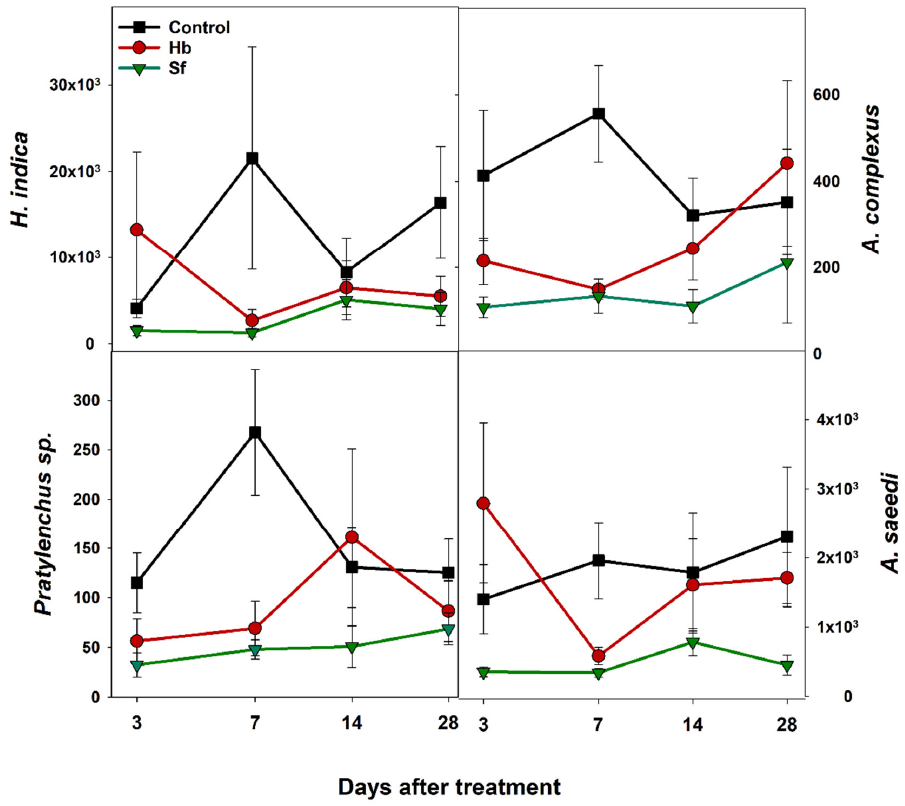
Figure 2. Read abundance of four indigenous nematode species in a citrus orchard for 28 days following augmentation of Steinernema feltiae (Sf), Heterorhabditis bacteriophora (Hb) or no augmentation (Ctrl). Error bars are SE of the